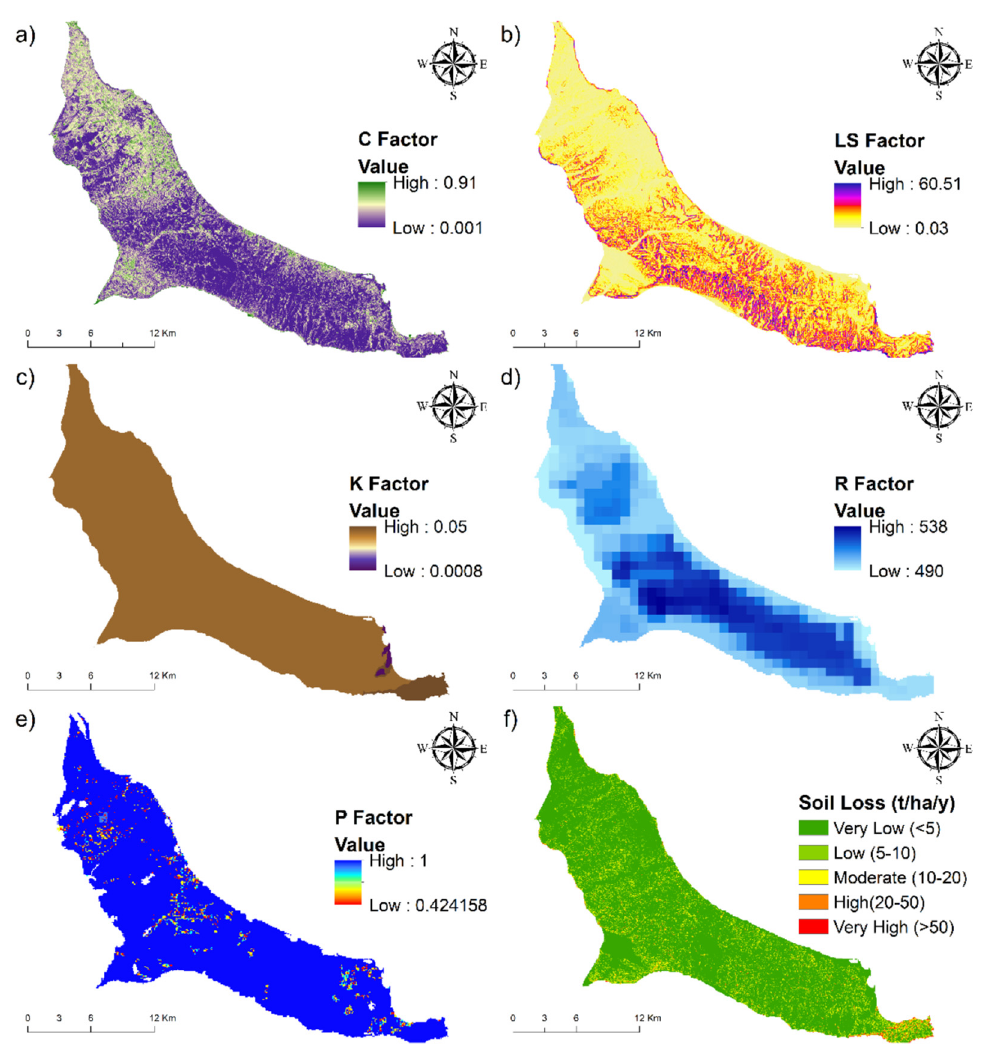
Figure 3. Spatial distribution of ( a ) cover management factor ( C ), ( b ) topographic factor ( LS ), ( c ) soil erodibility factor ( K ), ( d ) current rainfall erosivity factor ( R ), ( e ) support practice factor ( P ) and ( f ) soil loss.